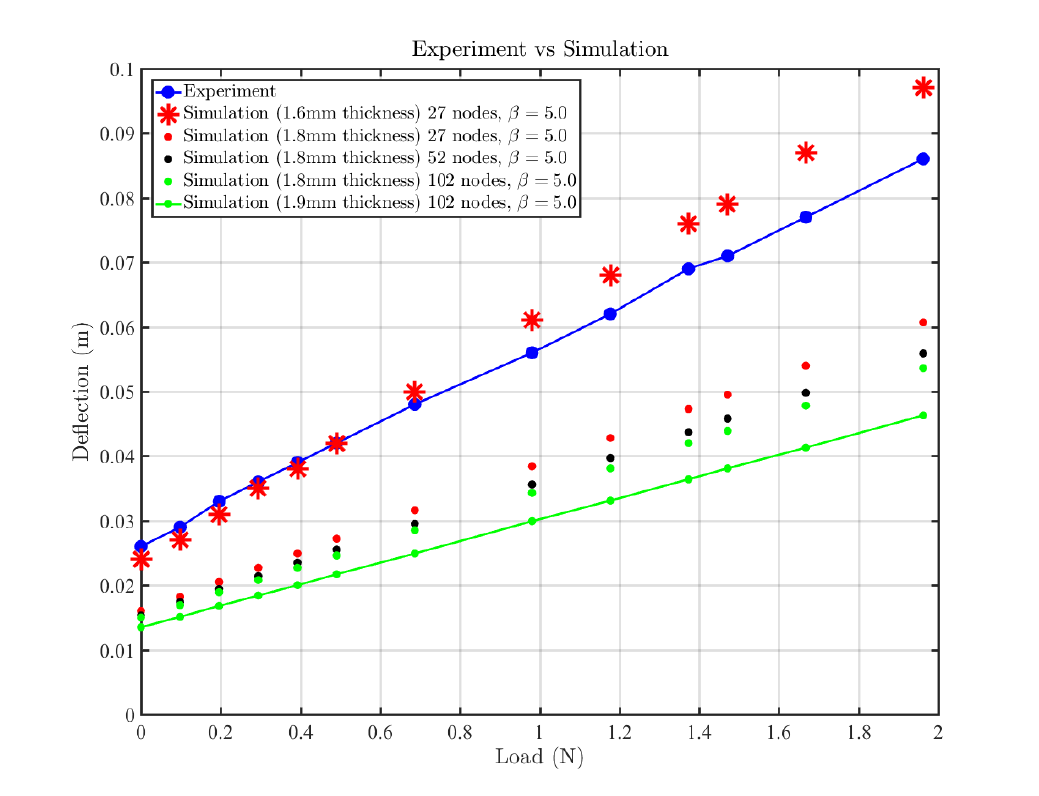
Figure 13. Experiment versus